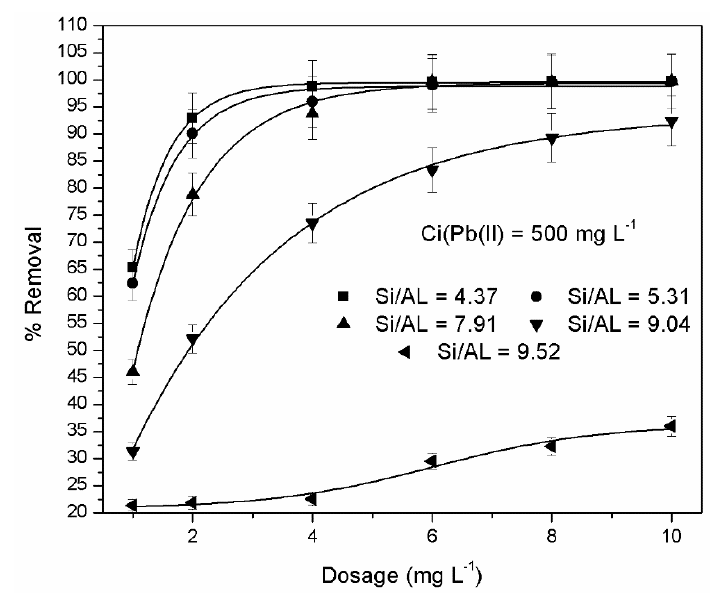
Figure 9. E ff ect of dosage of non- and acid-modified clinoptilolite-rich tu ff on Pb(II) removal e ffi ciency. Figure 9. Effect of dosage of non- and acid-modified clinoptilolite-rich tuff on Pb(II) removal efficiency.